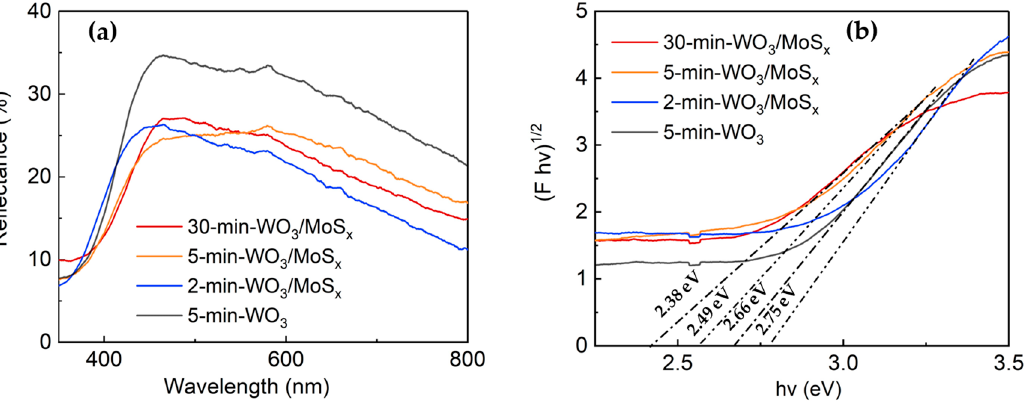
Figure 6. Di ff use re fl ectance spectra ( a ) and Tauc plots with band gap calculations ( b ) of WO 3 /MoS x and 5-min-WO 3 fi lms. and 5-min-WO 3